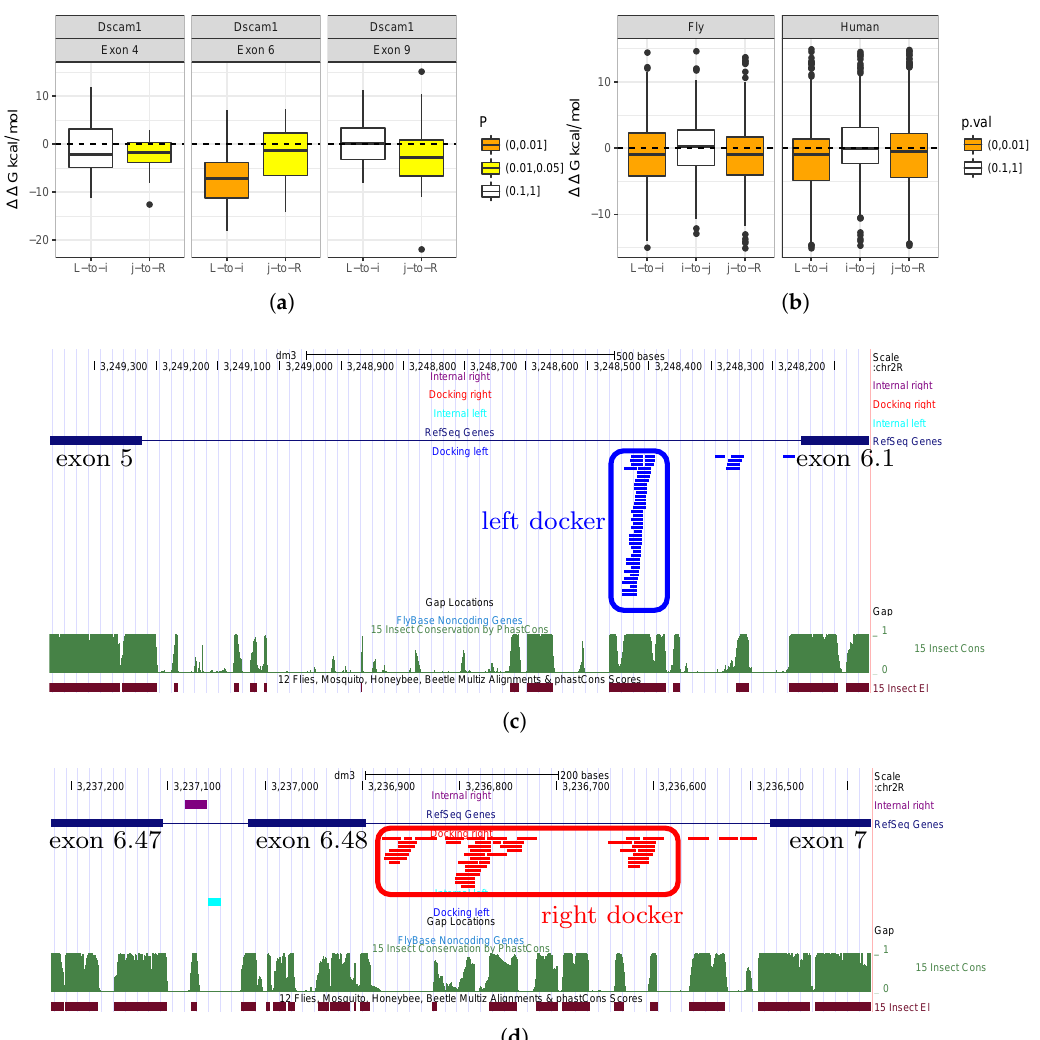
Figure 2. ( a ) The distribution of the minimum free energy (MFE) differences ∆∆ G = ∆ G − ∆ G 0 , where ∆ G is the MFE of hybridization of the actual pair of introns (L-to-i and j-to-R), and ∆ G figure for shuffled sequences, for the three largest MXE clusters of Dscam . ( b ) The distribution of the minimum free energy (MFE) differences for the actual pair of introns (L-to-i, i-to-j, and j-to-R) in fruit fly and human MXE clusters with two exons. Color codes show the significance according to the Wilcoxon signed rank test. ( c , d ) The predicted docker sequences in the left intron (blue) and in the right intron